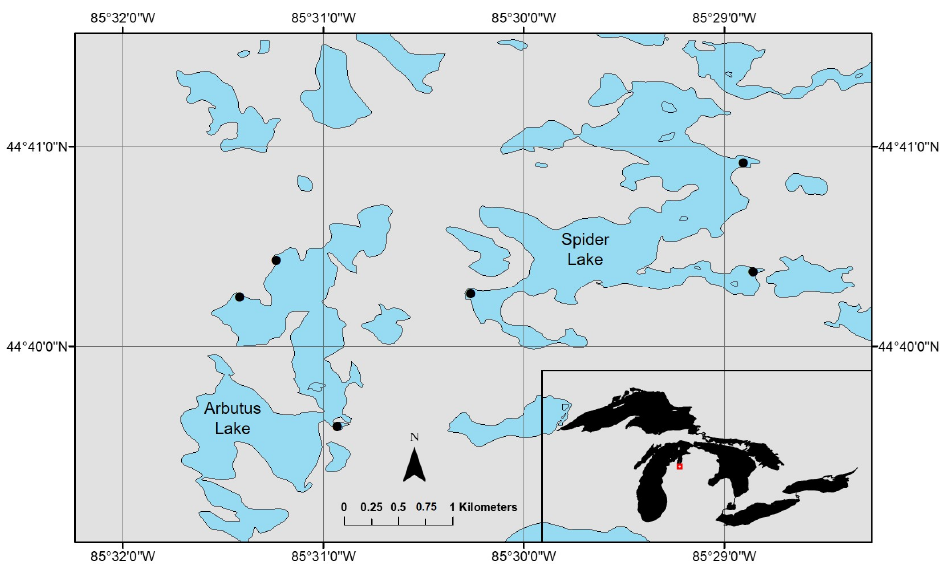
Figure 1. Locations of Arbutus and Spider Lakes in Michigan, USA. The black circles on the map indicate each bay that was sampled in each lake during the study period. Each sampling location consists of both where bladderwort traps were collected in the littoral zone and where zooplankton were collected by tow nets just adjacent to the plants in the pelagic zone. The red circle in the inset map indicates the specific location of these lakes in Michigan’s Lower Peninsula.